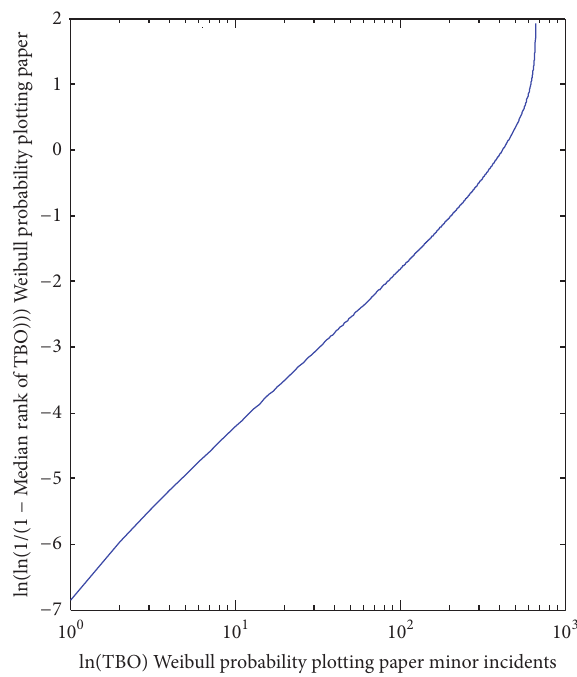
Figure 1: Weibull paper for minor incident 2010 to 2015.